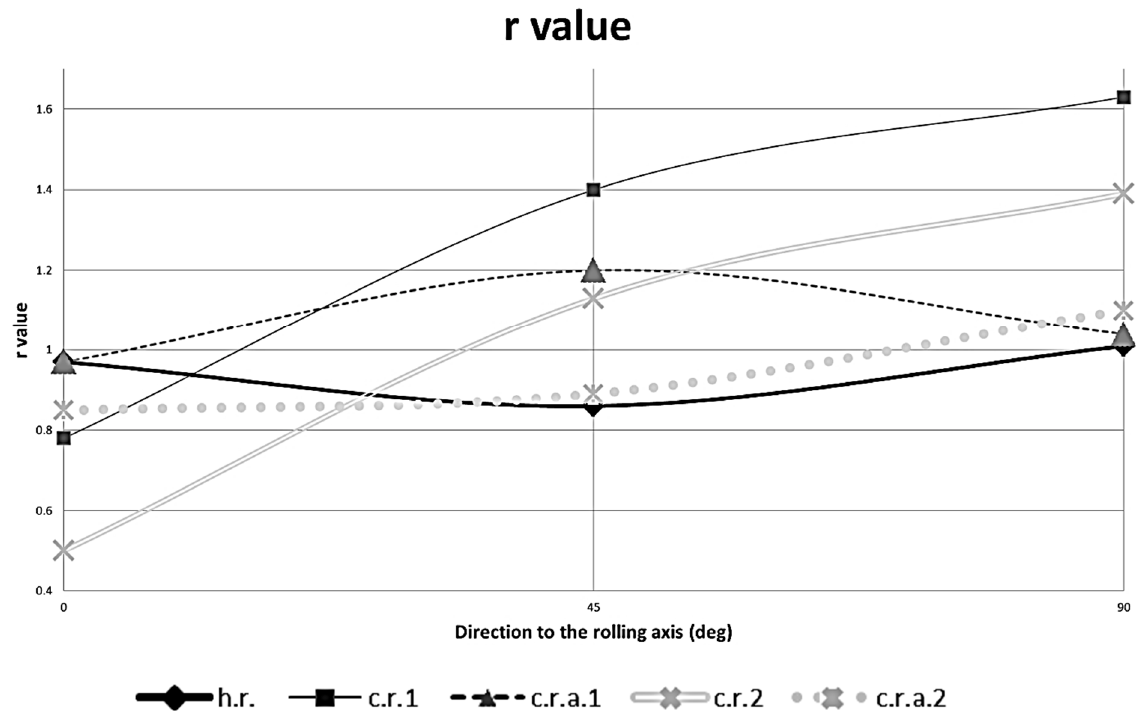
Figure 9. The r average in relation to direction (0°, 45°, 90°).